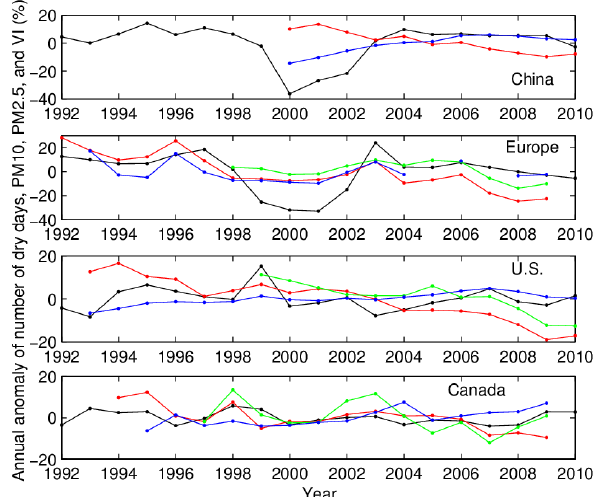
Figure 9. Annual anomaly of normalized number of dry days (black), PM10 (red), Fig. 9. Annual anomaly of normalized number of dry days (black), PM2.5 (green), and optical extinction coefficients (inverse of visibility, blue) PM 10 (red), PM 2 . 5 (green), and optical extinction coefficients (in- verse of visibility, blue) averaged from sites where PM 10 data are available for more than 120 months for Europe and the US and for more than 60 months for China and Canada.